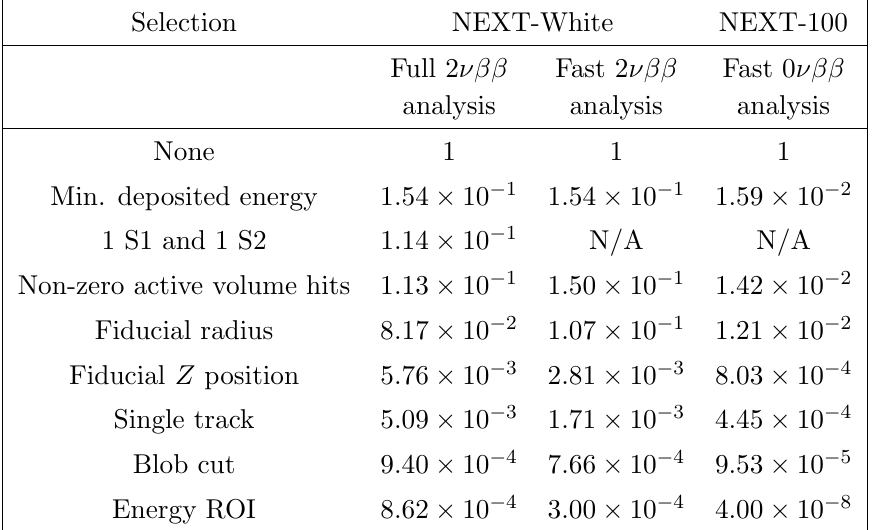
Energy ROI: The event energy E is obtained by summing the hit charges after cor- reco recting for detector non-uniformities in response, and after applying an energy scale factor to convert PEs into keV. Only events within the energy region of interest (ROI), de(cid:12)ned in the 2 (cid:23)(cid:12)(cid:12) case to be E > 700 keV, are reco